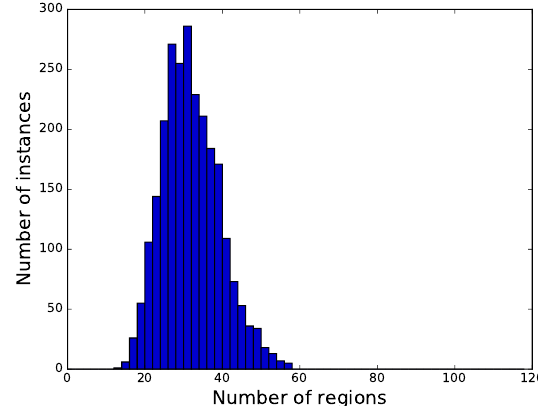
Figure 5. Posterior distribution of the number of unknowns in the pseudo-data